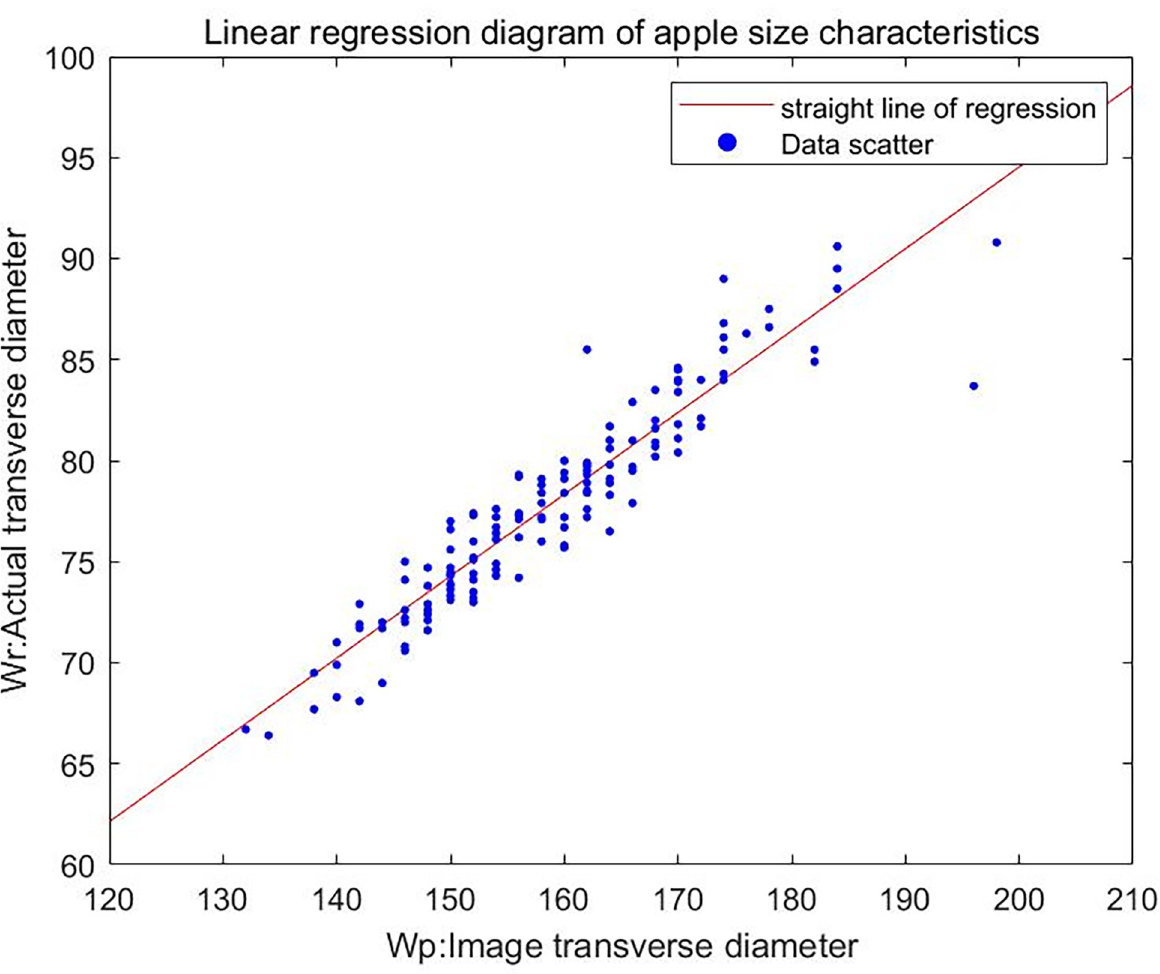
Fig 8. Linear regression plot of the apple size characteristic.